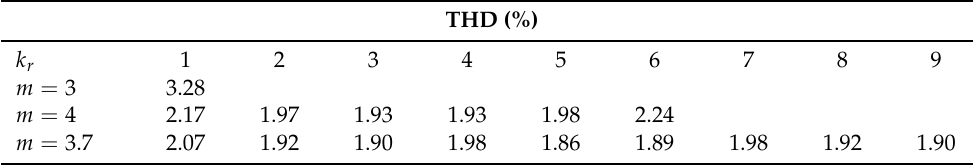
Table 3. Comparison of m = 3, m = 4 and m = 3.7 under difference k r .